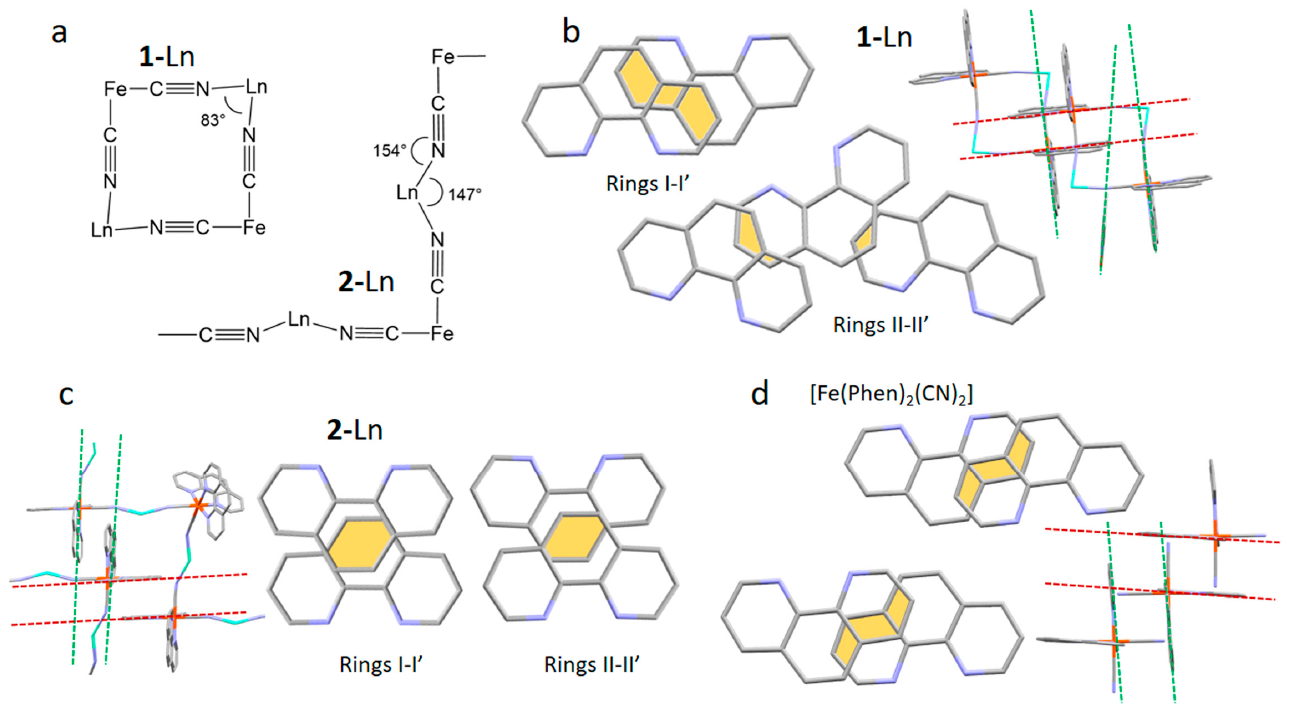
Figure 2. ( a ) Comparison of the tetranuclear and chain-like arrangement of compounds 1 -Ln and 2 -Ln and ( b – d ) schematic representation of the overlap (evidenced in yellow) of phenanthroline rings related by short contact interactions ( π -stacking) in 1 -Ln, 2 -Ln and [Fe(Phen) 2 (CN) 2 ], respectively. Dashed lines represent the phenanthroline rings(cid:31) planes.